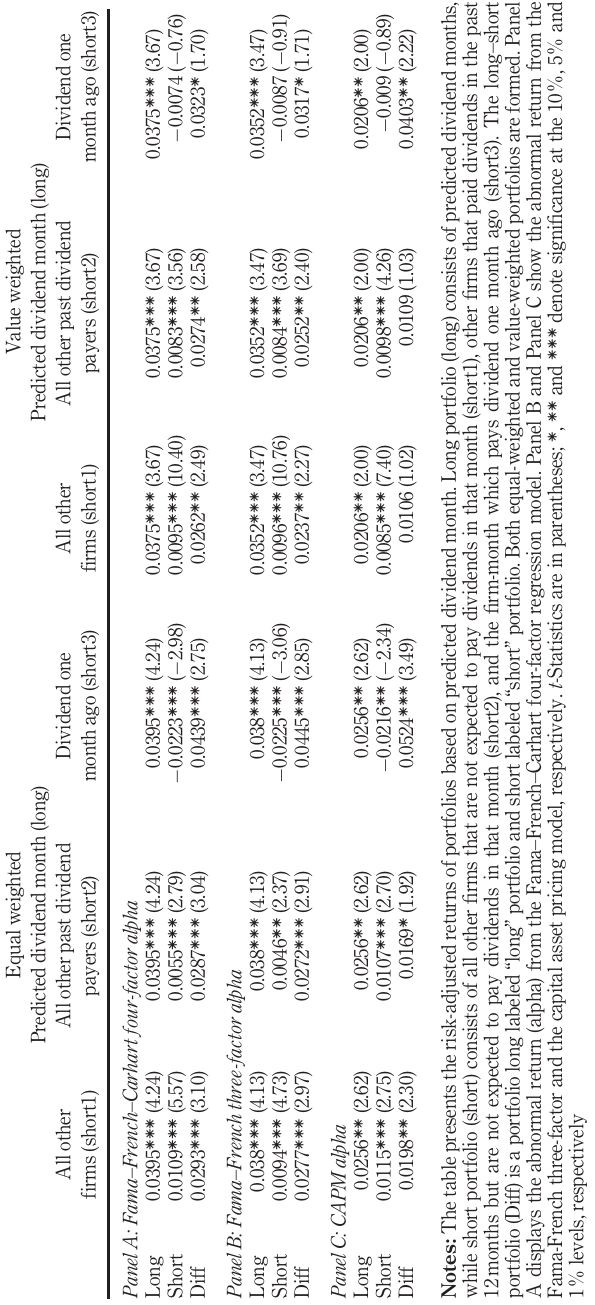
Table 5. Risk-adjusted returns in predicted dividend